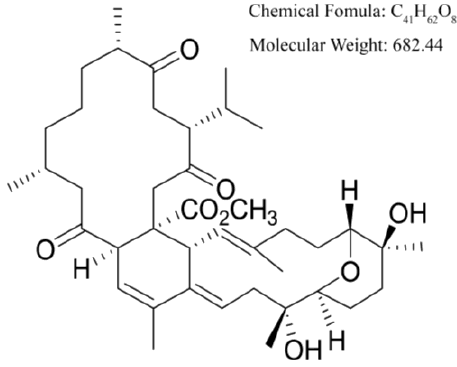
Figure 8. Chemical structure of Methyl